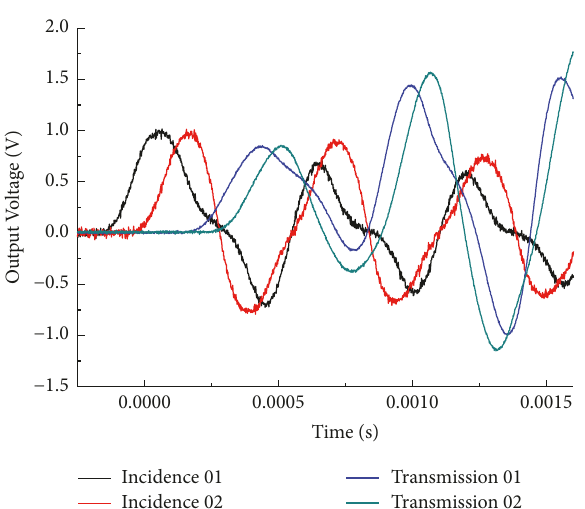
Figure 4: Typical waveforms obtained by two-point strain measure- ment.